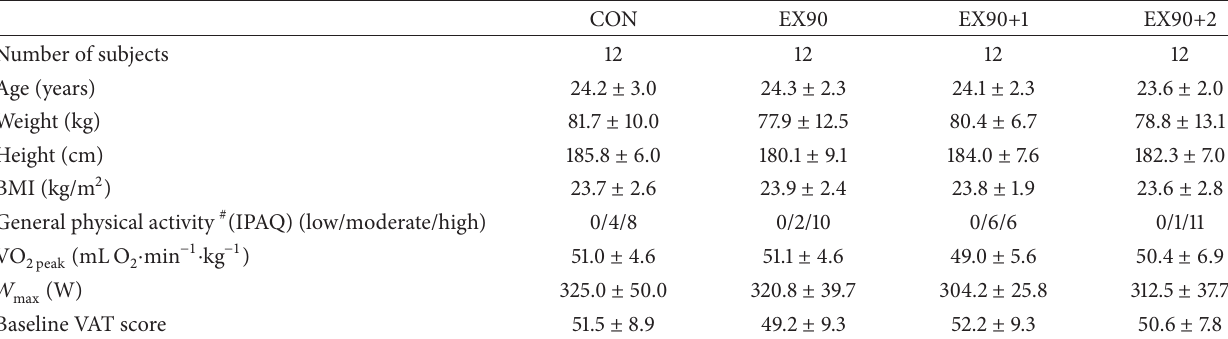
Table 1: Baseline characteristics of study subjects (mean ± SD).